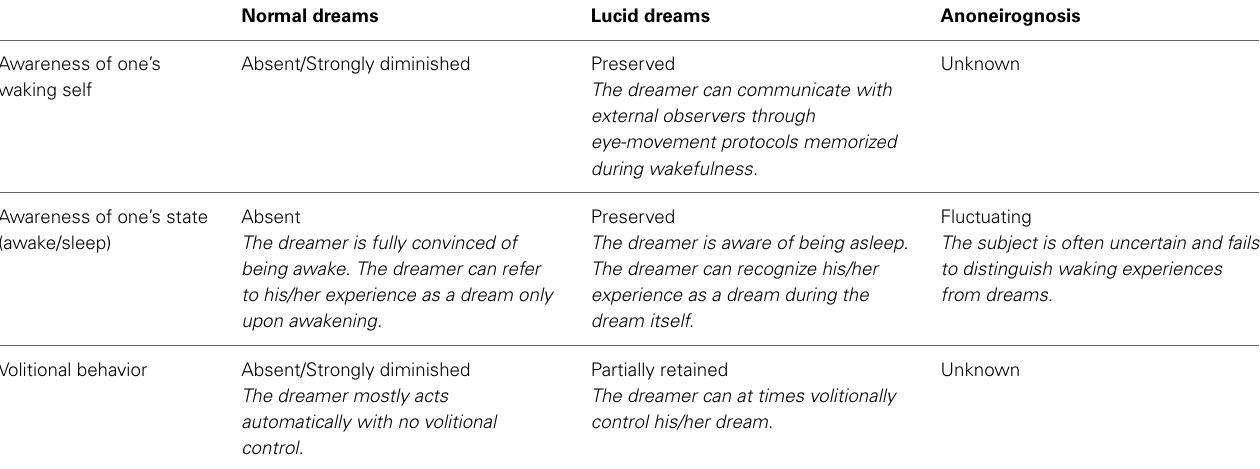
Table 1 | Major differences between normal dreaming, lucid dreaming, and anoneirognosis.